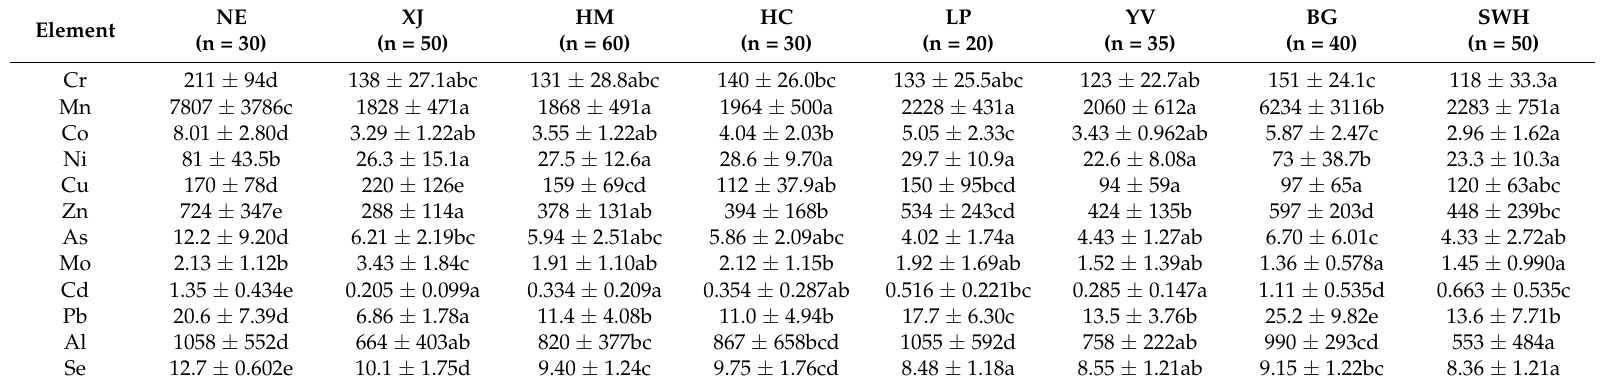
Table 2. Concentrations (mean ± SD, µ g/L) of trace elements in 315 wines of different